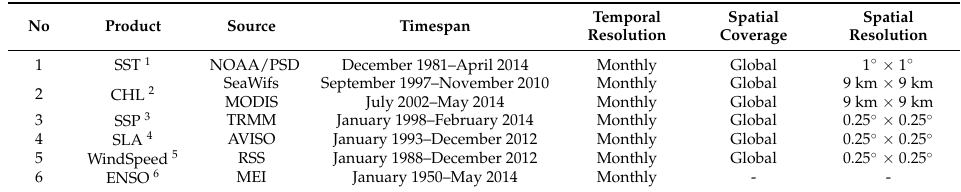
1 Provided by National Oceanic and Atmospheric Administration (NOAA)/The Office of Oceanic and Atmospheric Research (OAR)/Earth System Research Laboratory (ESRL) Physical Sciences Division (PSD) [35]; 2 Obtained from the Sea-Viewing Wide Field-of-View Sensor (SeaWiFS) and Moderate Resolution Imaging